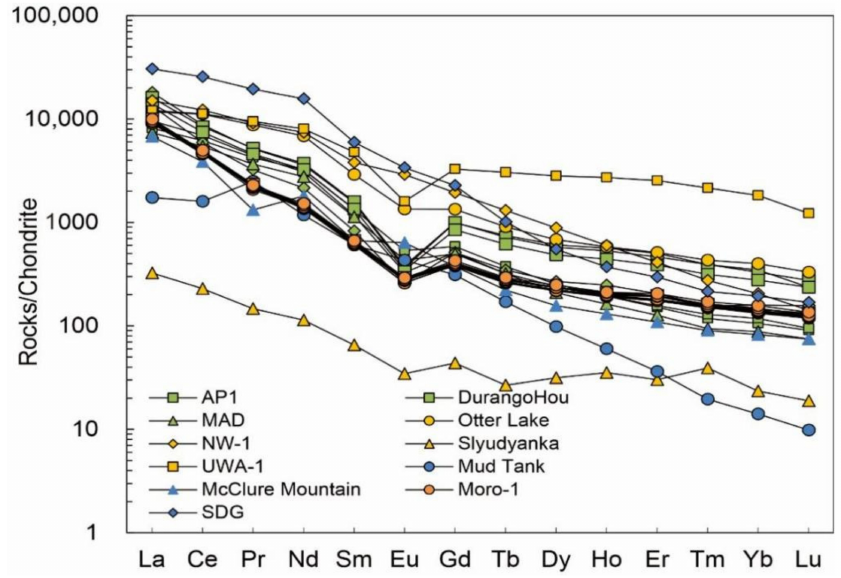
Figure 11. Chondrite-normalised REE distribution patterns of the apatite reference materials analysed in this study. The normalisation values for chondrite are from McDonough and Sun (1989)